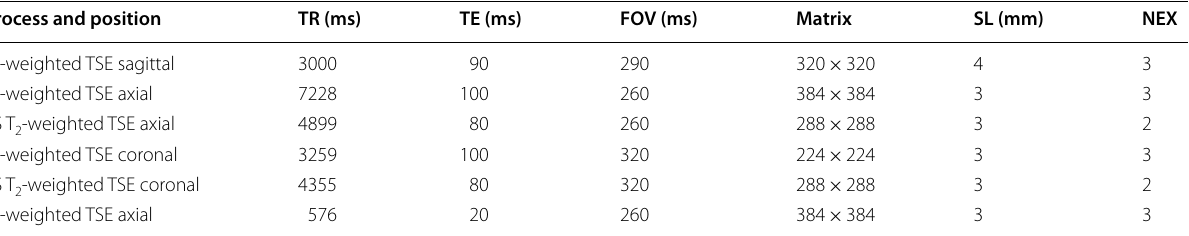
FOV field of view, FS fat-saturated, NEX number of excitations, SL slice thickness, TE echo time, TR repetition time, TSE turbo spin-echo